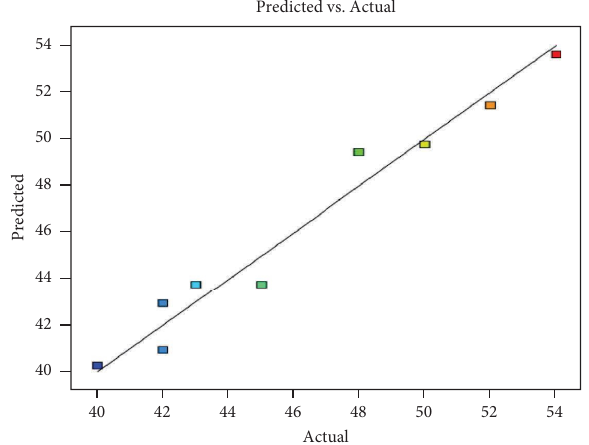
Figure 8: Simulated and actual outcome for slump.